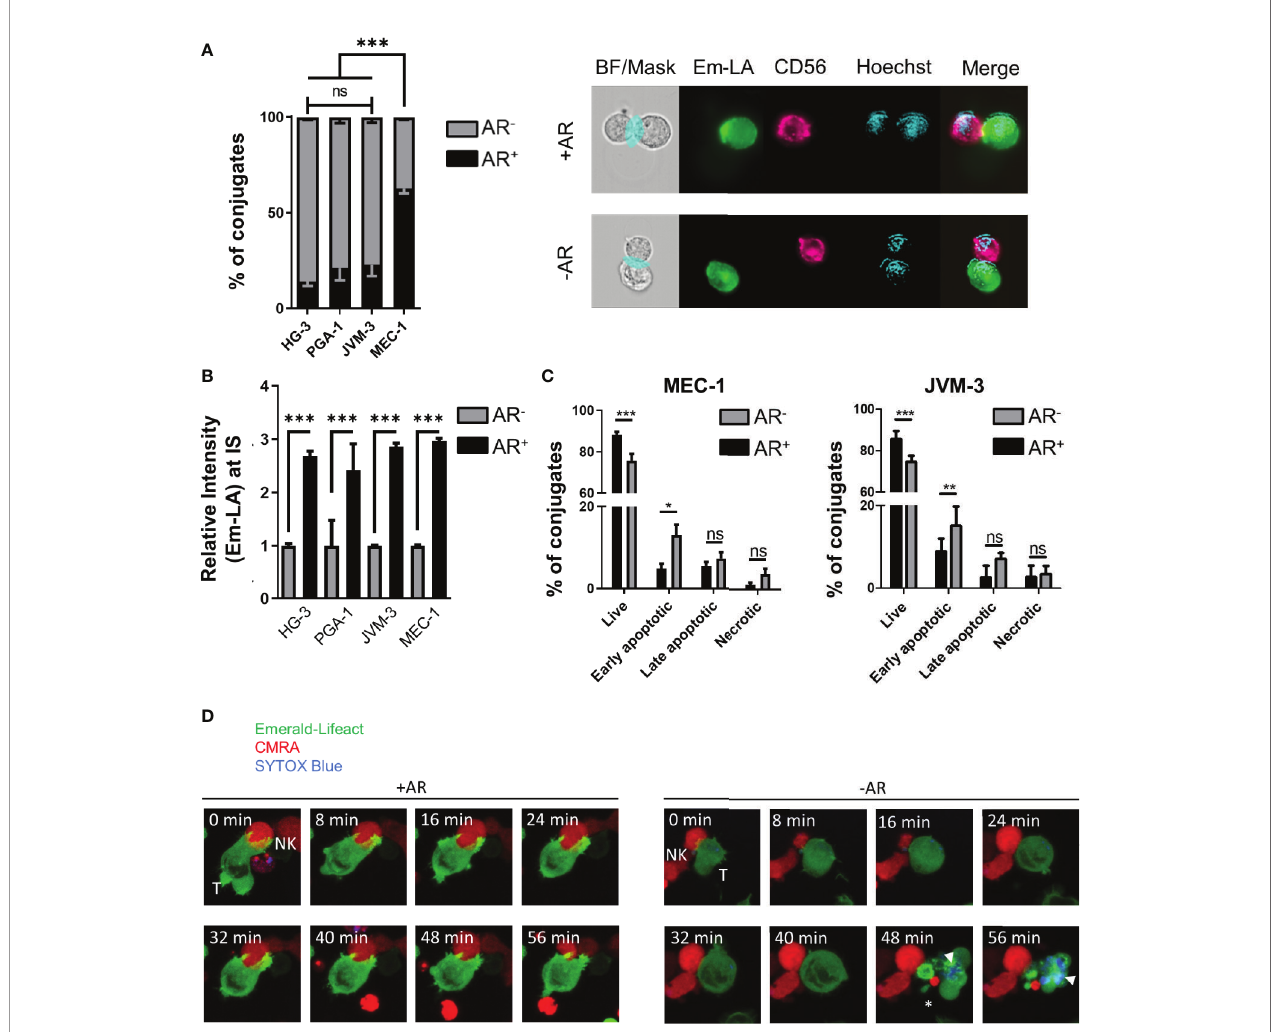
FIGURE 2 | Quanti fi cation and functional consequence of the actin response during NK cell attack. (A) Quantitative Imagestream analysis of CLL-NK cell conjugates. CLL cells HG-3, PGA-1, JVM-3 and MEC-1 were analyzed for their actin response frequency in conjugates with NK-92MI cells. Percentages of target cells in conjugation with NK-92MI cells with (black, AR + ) and without (grey, AR - ) an actin response. *** denotes p < 0.0001 (B) Relative intensity of Emerald-Lifeact at the IS in target cells conjugates with NK cells with respect to absence (grey, AR - ) to presence (black, AR + ). Data represents results of 6 different experiments and plots over 2000 conjugates per cell line. Data was normalized to conjugates without an AR. *** denotes p < 0.0001 (C) Imagestream analysis of target cell death in CLL target cells conjugated with NK cells in the presence (black, AR + ) or absence (grey, AR - ) of an actin response. Target cell death was assessed by Annexin V and propidium iodide staining. * denotes p<0.05, ** denotes p< 0.001, *** denotes p < 0.0001 (D) Time lapse imaging of actin dynamics in MEC-1 CLL cells upon NK cell attack. The AR + target cell can resist NK cell-induced cell death. Target cells not capable to produce an actin response are effectively lysed as seen by the SYTOX blue staining (white arrow head) and disappearance of normal cellular structures and membrane blebbing (asterisk). ns, non signi fi